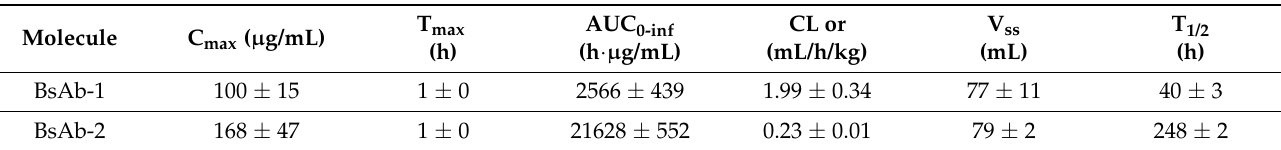
Table 3. Cynomolgus Monkey Pharmacokinetic Parameters of the BsAbs following a single IV administration of 5